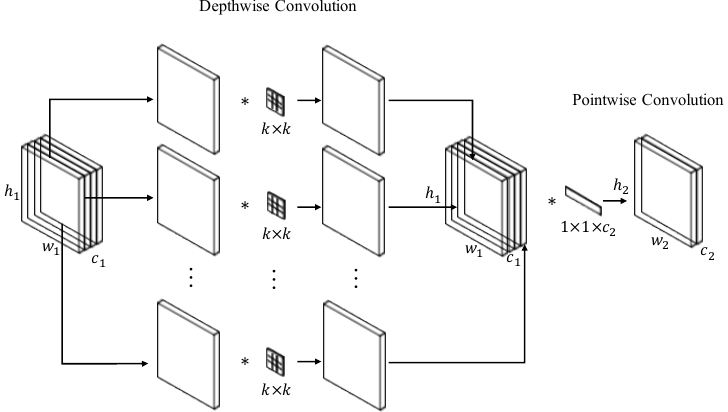
Figure 3. Depthwise Separable Convolution. A standard convolution is factorized by a depthwise convolution and a point-by-point